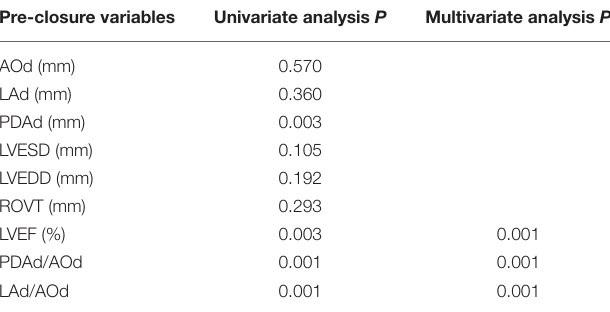
TABLE 4 | Multiple linear regression analysis for post-closure LV